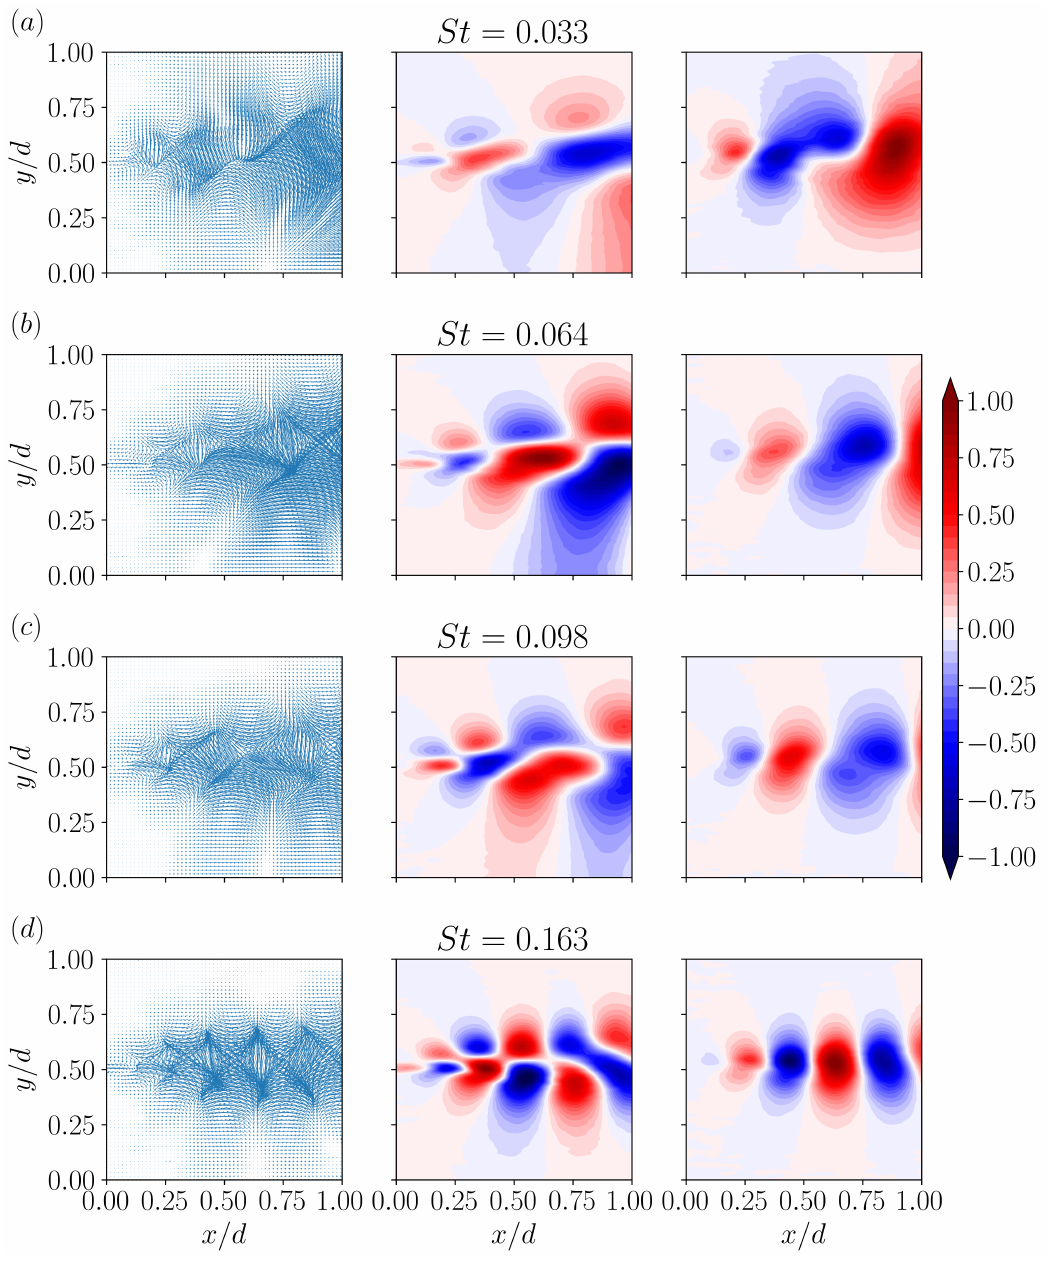
Figure 10. DMD modes visualised by the real part of the fluctuating velocity vectors (left column) and contours of their streamwise (middle column) and transverse (right column) components corre- sponding to ( a ) St = 0.033; ( b ) St = 0.064; ( c ) St = 0.098; ( d ) St =